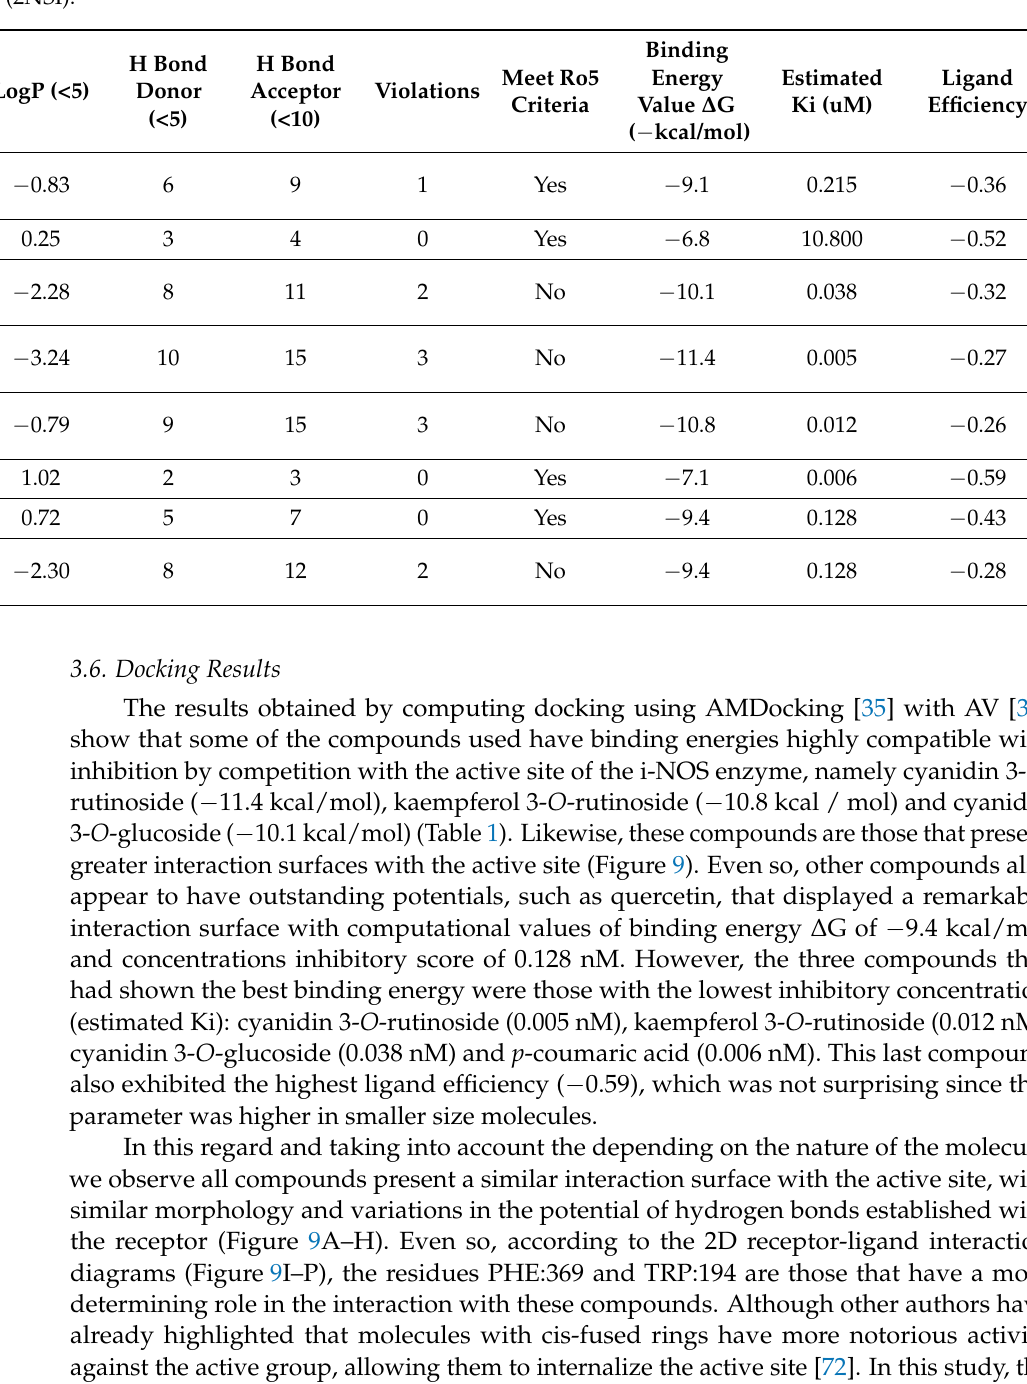
Table 1. Lipinski’s rule of five (RO5) of i-NOS ligands and molecular docking analysis of its against human self-inducible nitric oxide synthase